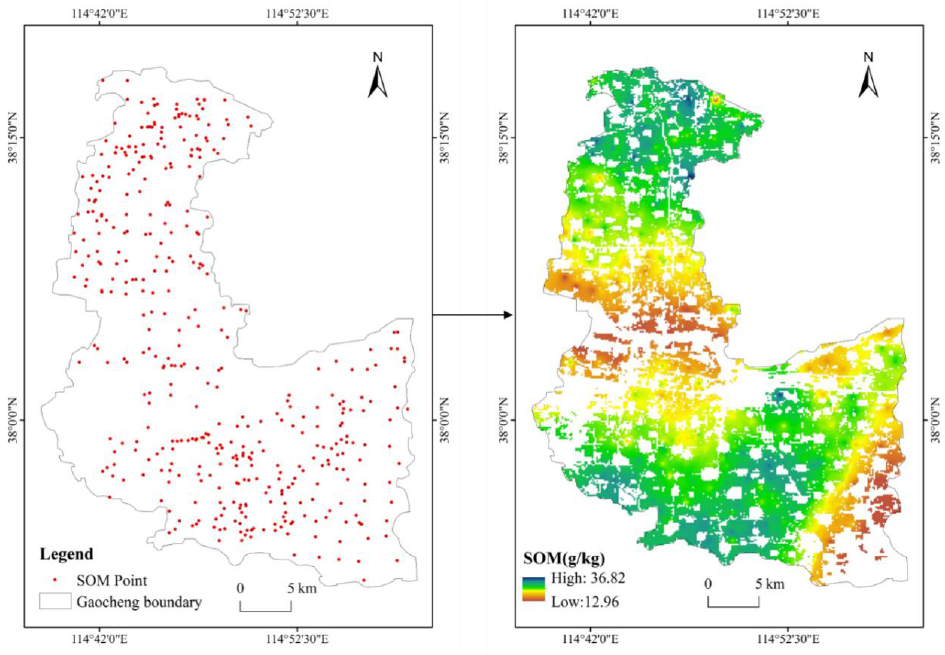
Figure 10. Spatial distribution map of soil organic matter (SOM) in